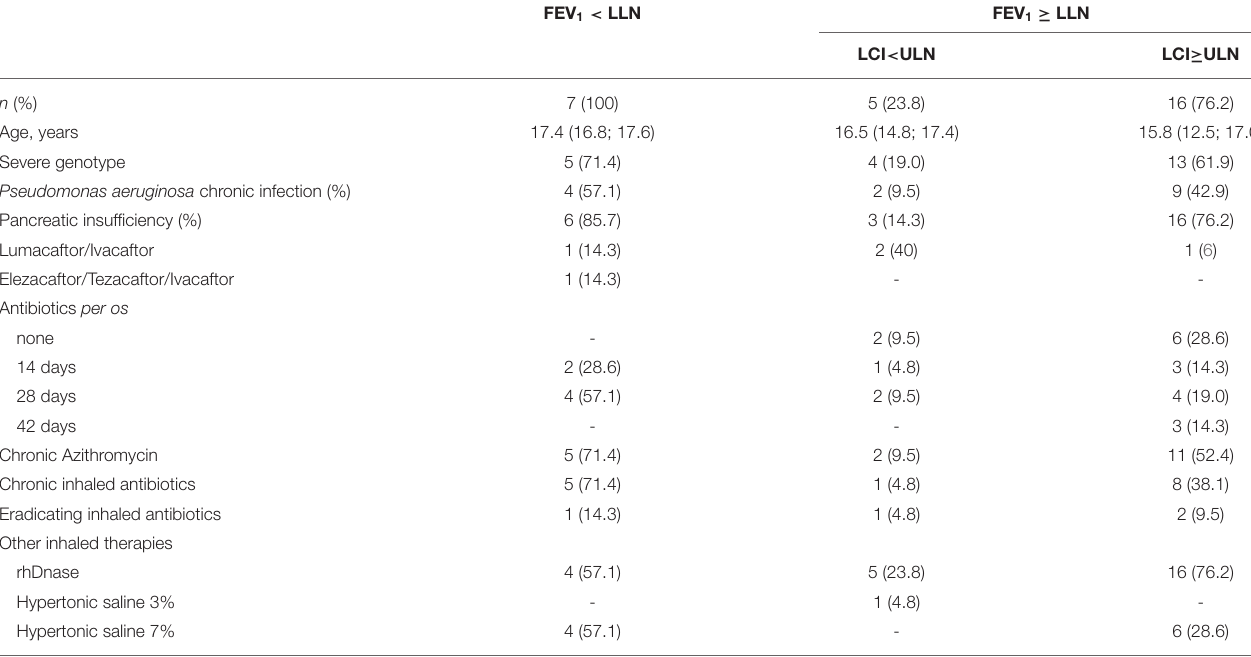
TABLE 3 | Clinical characteristics and medical therapy details stratified by FEV 1